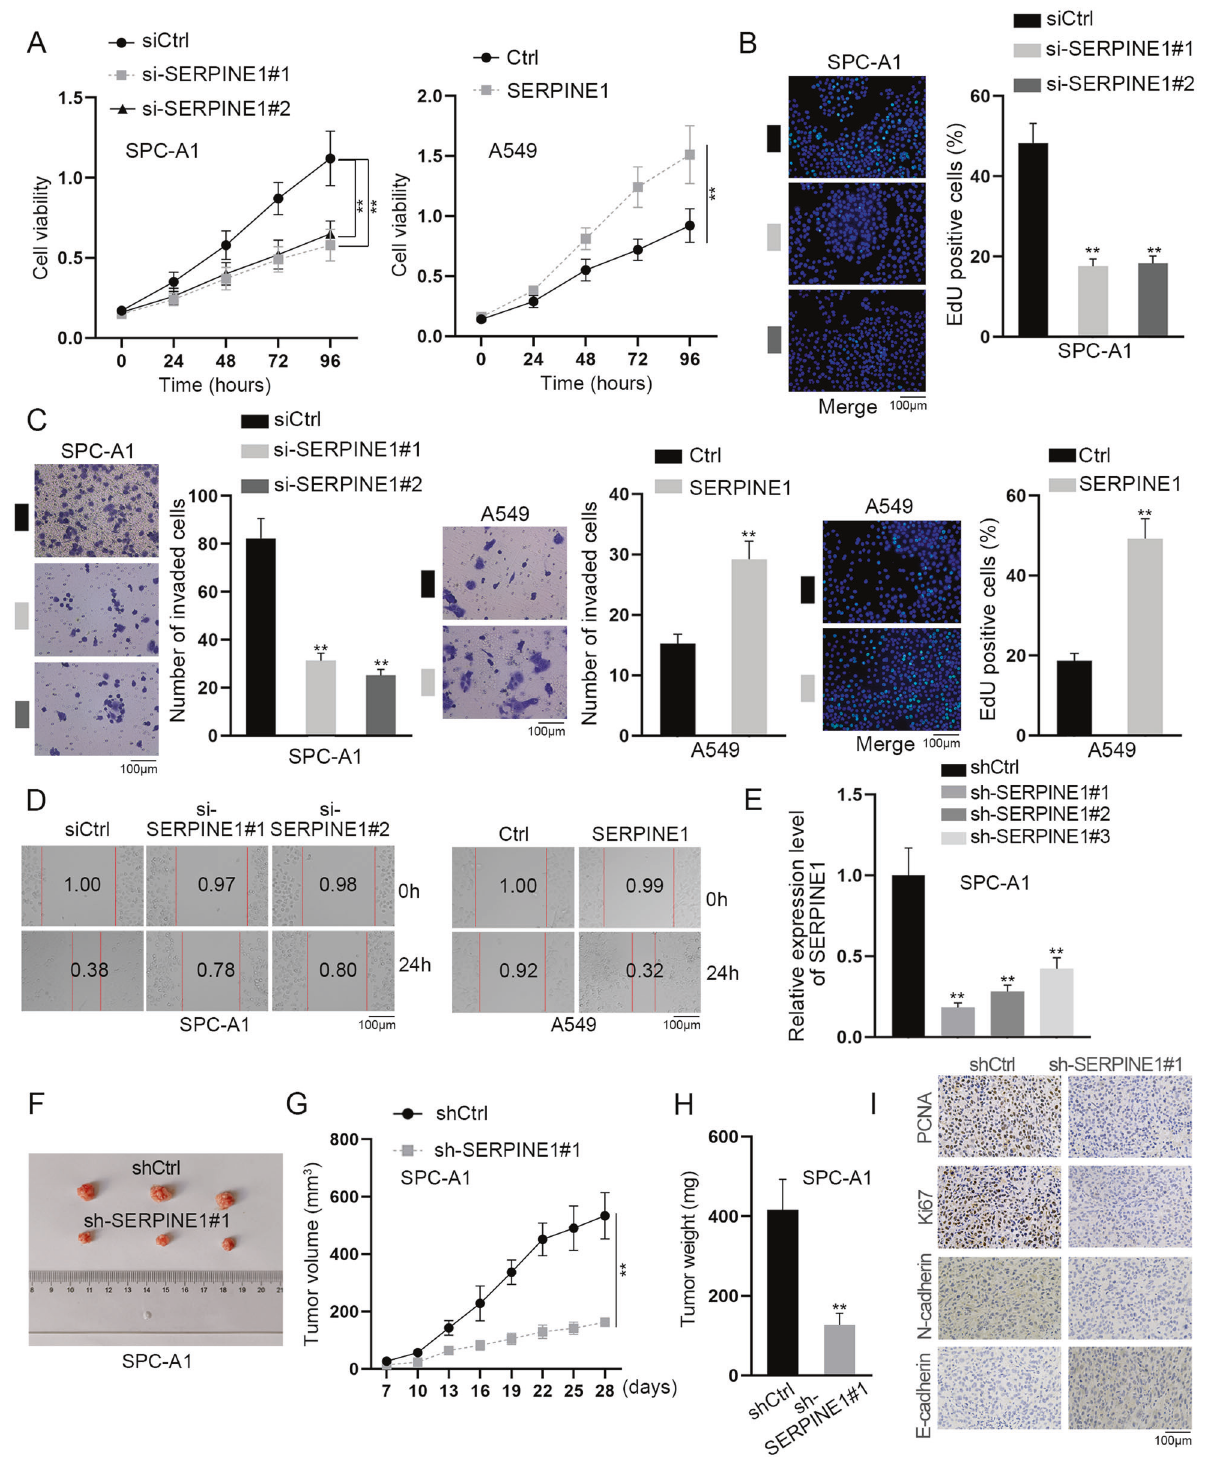
Fig. 7 SERPINE1 promotes LUAD cell proliferation, migration and invasion in vitro and facilitates tumor growth in vivo. A , B Proliferative ability of SPC-A1 and A549 cells was examined via CCK-8 and EdU assays after indicated transfections. C , D Cell invasion and migration were analyzed through implementation of transwell assay and wound healing assay after transfection of indicated plasmids. E RT-qPCR was done to determine sh-SERPINE1 knockdown ef fi ciency in SPC-A1 cells. F – H Animal experiments were done to evaluate SERPINE1 impacts on tumor growth. Representative images of tumors were displayed, and tumor volume and weights were also analyzed. I IHC was done to evaluate PCNA, Ki67, N-cadherin, and E-cadherin changes under the in fl uence of SERPINE1 silence. Results were exhibited as the mean ± SD on the basis of three independent experiments. ** p < 0.01 indicated the statistical signi fi cance of experiments data.